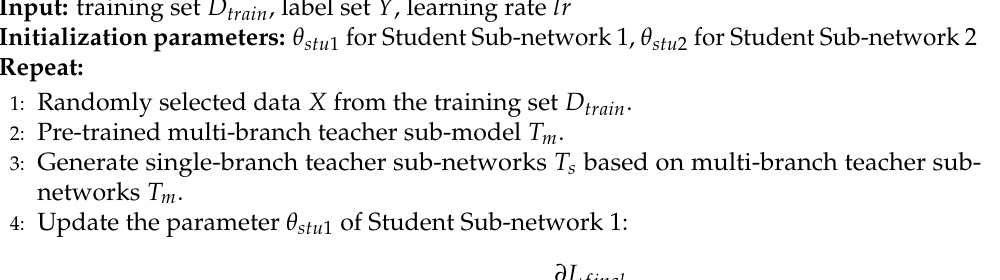
Algorithm 1 Collaborative consistency distillation